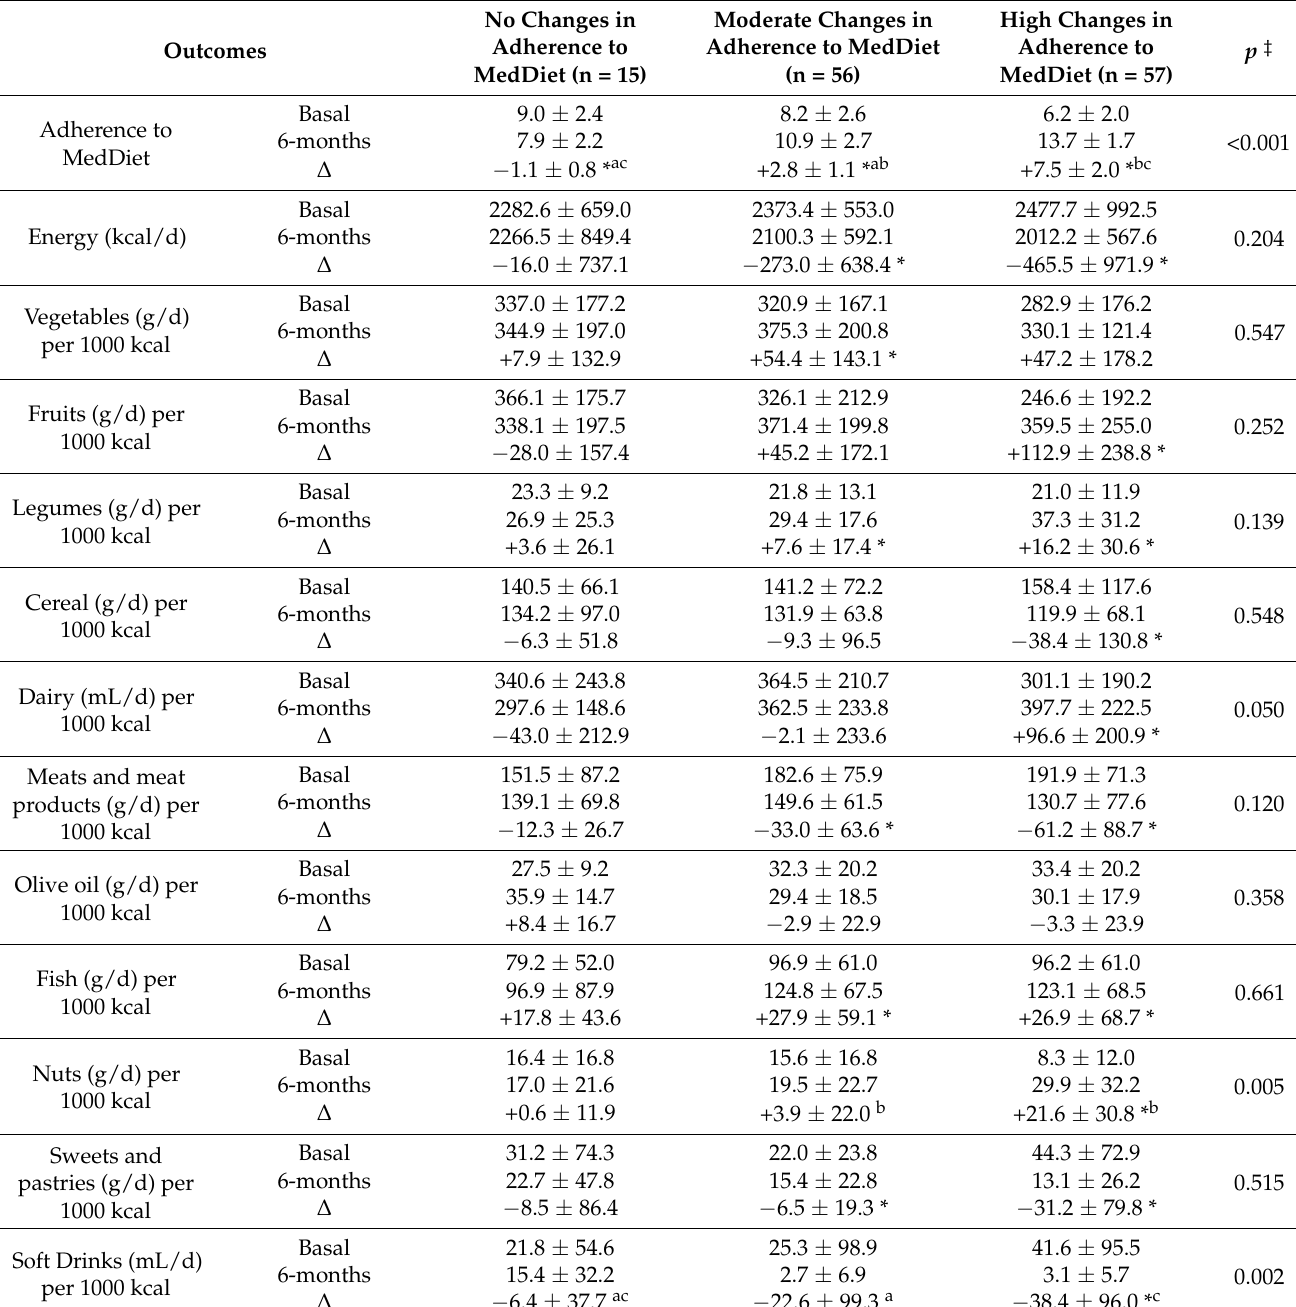
Table 3. Six-month follow-up changes on dietary features according to changes in adherence to